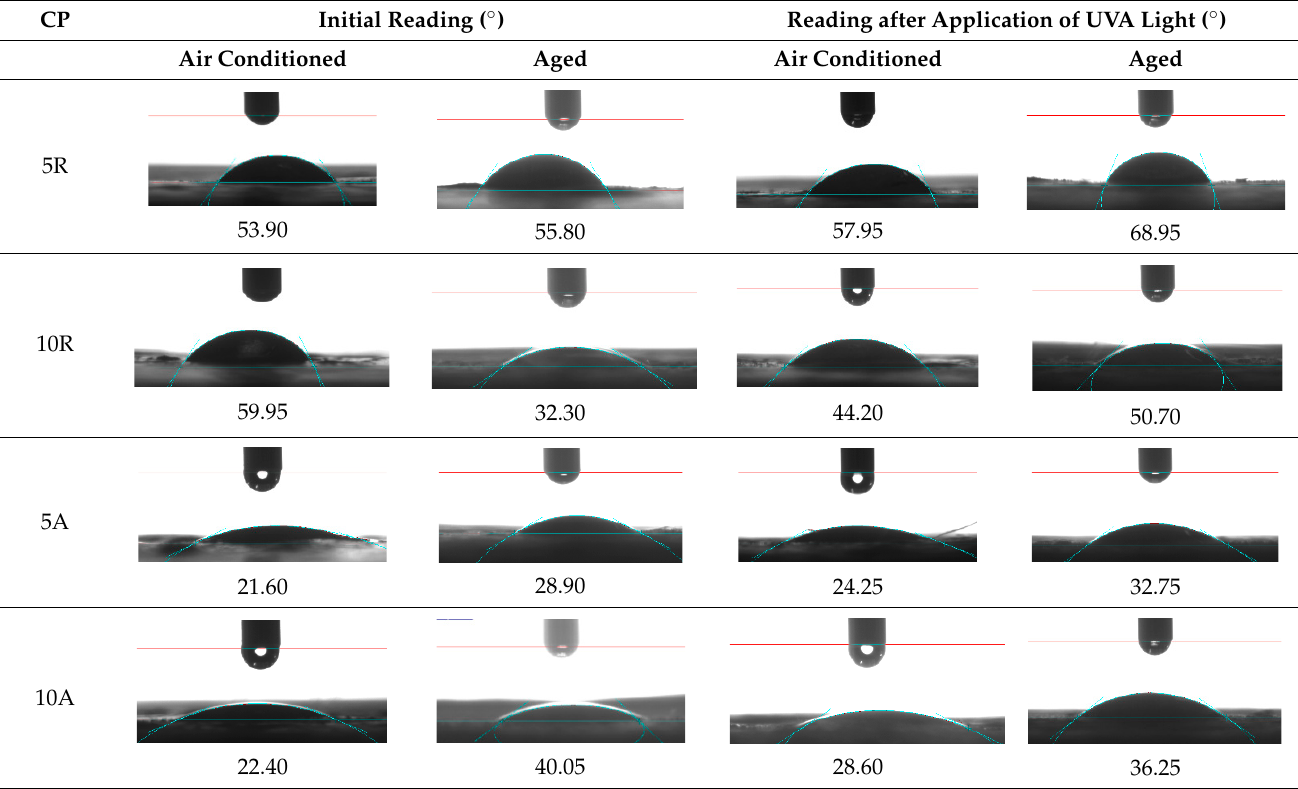
Table 10. Contact angle of a water drop on the surface of a cement tile, before and after application of UVA light, under air conditioned curing and accelerated aging.